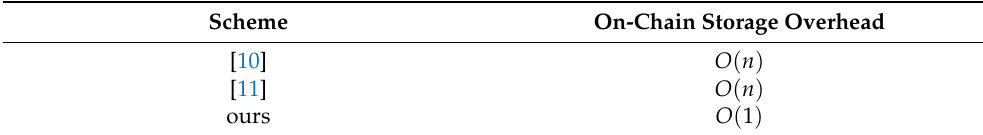
Table 6. Comparison of the relationship between on-chain storage overhead and the number of clients n .